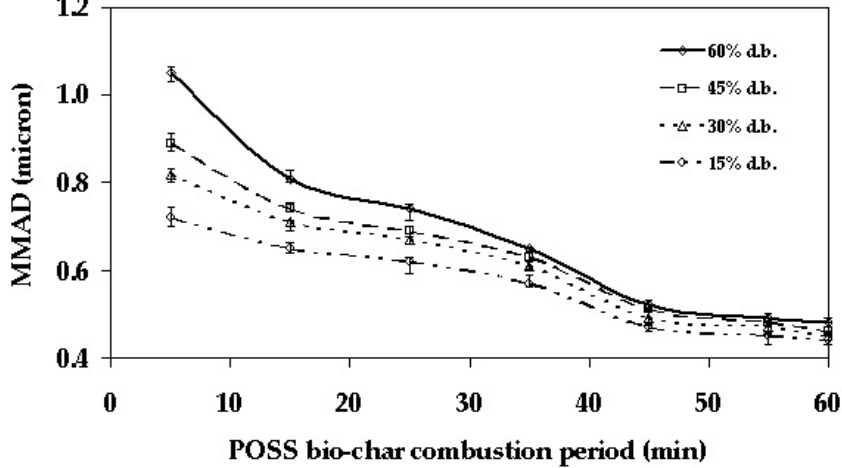
Figure 6. MMAD emission from the POSS bio-char combustion for different moisture contents.